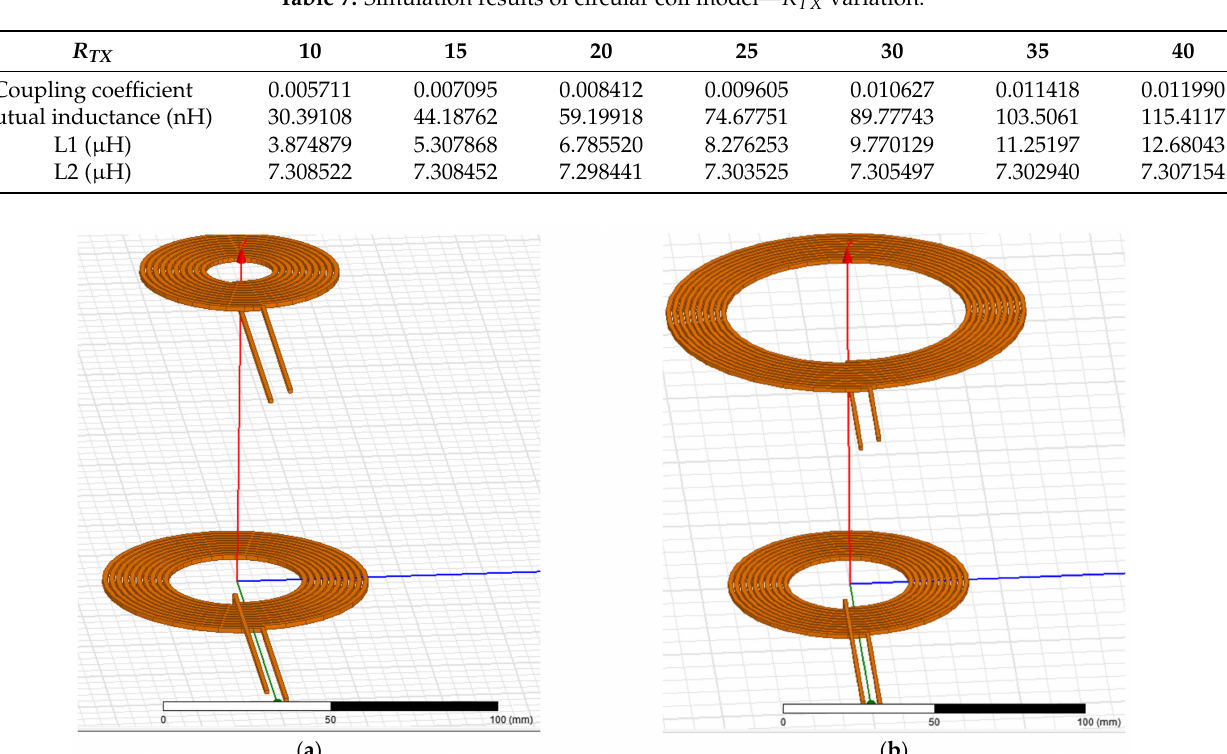
Figure 11. Coreless coil models with constant R TX : ( a ) R RX = 10 mm, ( b ) R RX = 40 mm for gap = 100 mm.